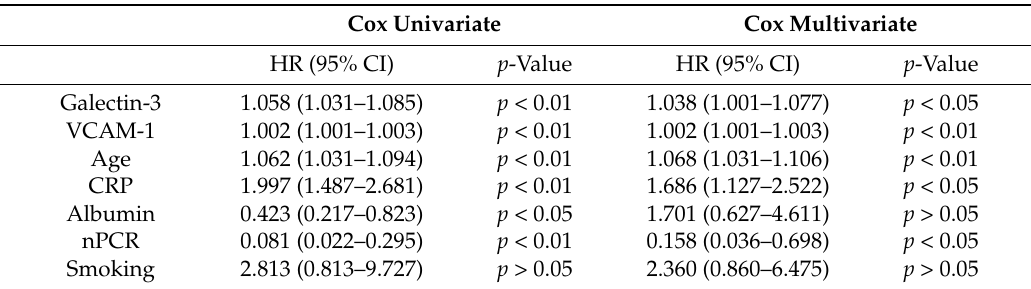
Table 3. Univariate and multivariable Cox regression analysis of prognostic factors for all-cause mortality.